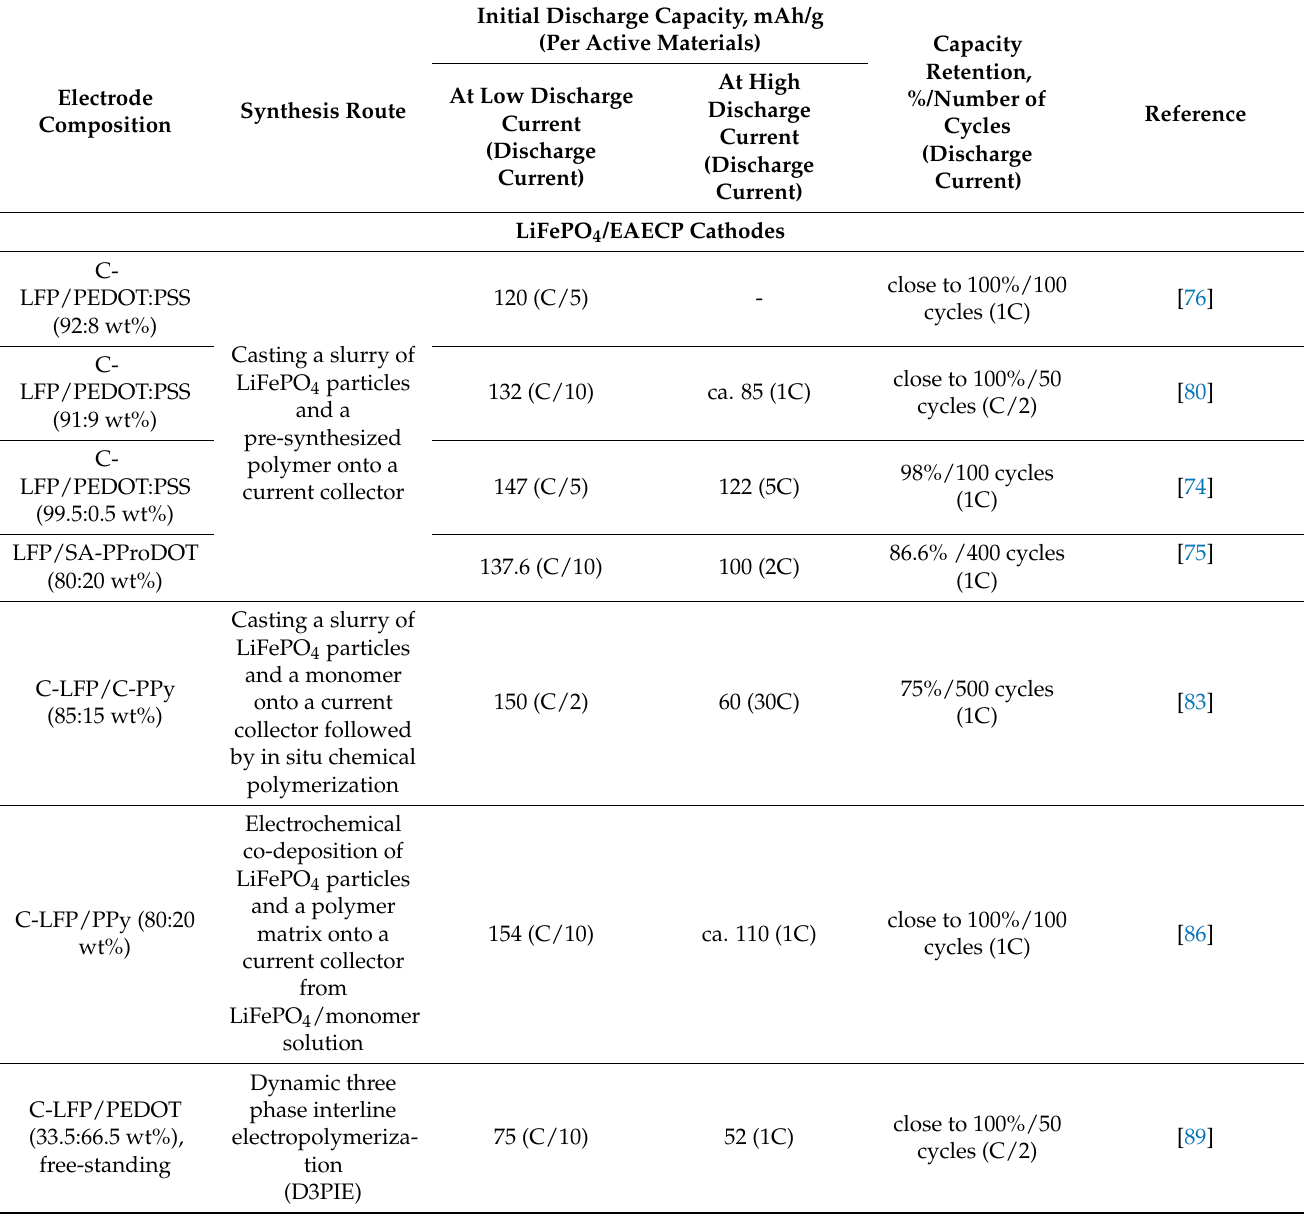
Table 3. Synthetic strategies and electrochemical performance of lithium iron phosphate electrodes containing EAECPs as conductive